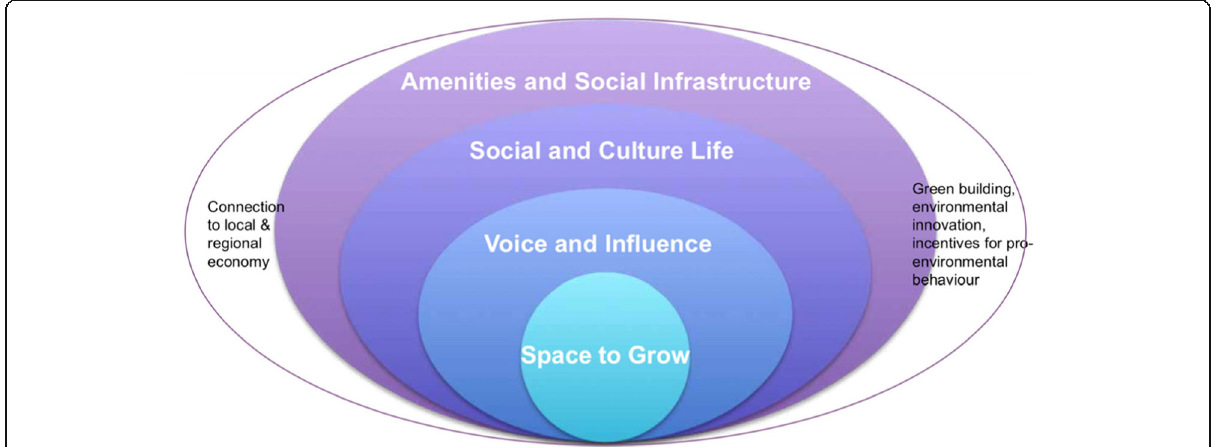
Fig. 2 A framework for social